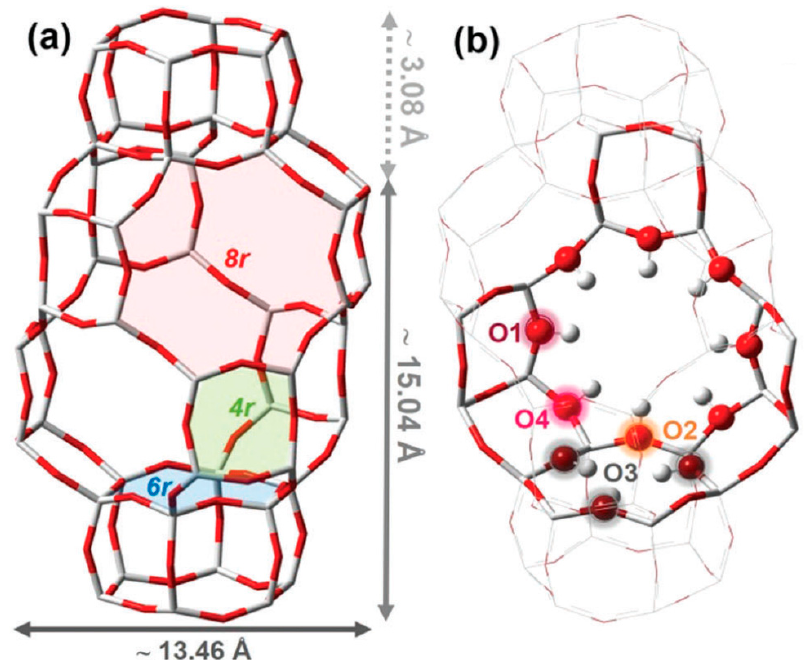
Figure 1. Representation of the CHA framework. The coloured areas in ( a ) marks the three different ring types (4MR, D6R and 8MR) surrounding the cages. ( b ) illustrates the four different O-sites in the framework. Colour code: grey: Si (SSZ-13) or alternating Al and P (SAPO-34), red: O, orange: Al (SSZ-13) or Si (SAPO-34). Adapted from Borfecchia et al. [29].